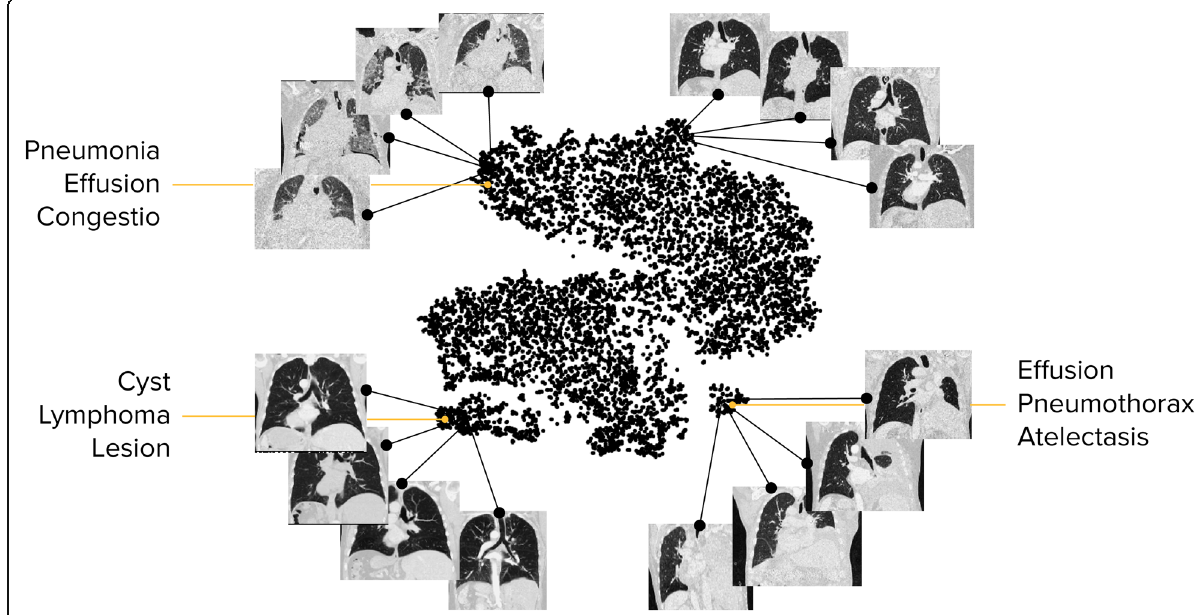
Fig. 9 The landscape of lung disease patients based on their CT image data. The distribution illustrates clusters of patients with similar imaging characteristics confirmed in reported findings. It is a step towards the identification of phenotypes in large-scale medical imaging data.